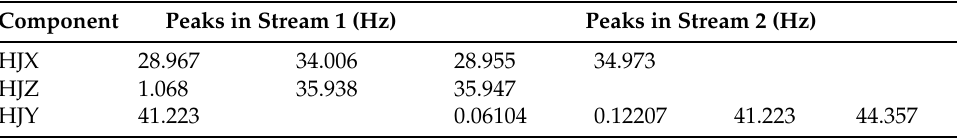
Table 6. Peak Frequencies (Hz) of the PSDs of streams 1 and 2 for each rotation